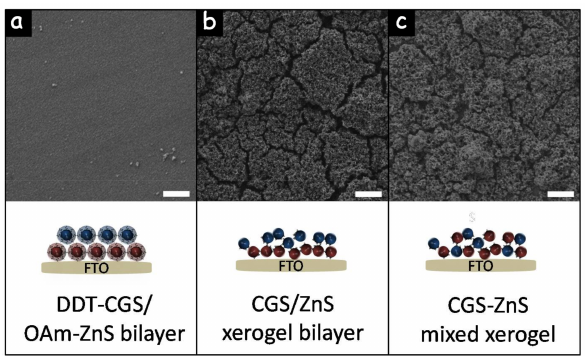
Figure 8. SEM micrographs and schematic representations of the following structures: ( a ) a bilayer obtained from the sequential spin coating of DDT-CGS NCs and OAm-ZnS NCs; ( b ) a bilayer produced from the spin coating and gelation of TGA-CGS NCs and the subsequent deposition and gelation of MUA-ZnS NCs; ( c ) a blended CGS-ZnS NC layer obtained from the spin coating of a solution containing both TGA-CGS NCs and MUA-ZnS NCs followed by treating it with TNM. Scale-bars = 1 µ m.